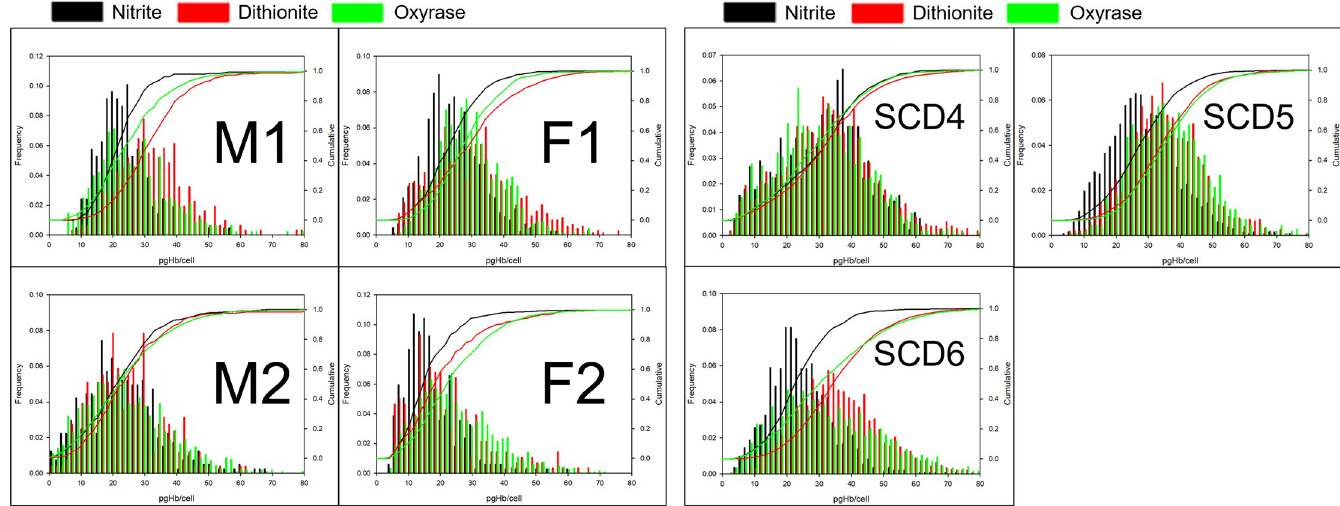
Fig 5. A. Picograms of Hb per cell for healthy donors. Using data from Fig 4 and the experimentally calculated Oxyrase viscosity from u s comparisons within a donor, CTV data are converted to histograms showing the intracellular mass of Hb; sodium nitrite (black), sodium dithionite (red) and Oxyrase (green). B. Picograms of Hb per cell for SCD donors. Overlaid histograms and cumulative curves of three SCD patients compare intracellular Hb concentrations for three treatments.